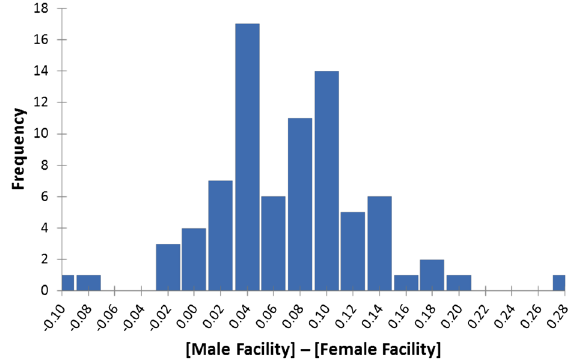
FIG. 2. Distribution of gender gaps ( ½ male facility (cid:2) ‐ ½ female facility (cid:2) ) on all ASOE MCQs from 2007 to